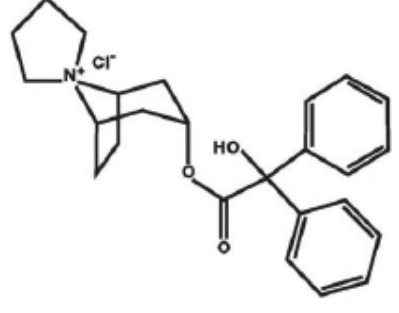
Figure 1 : Chemical structure of trospium chloride.